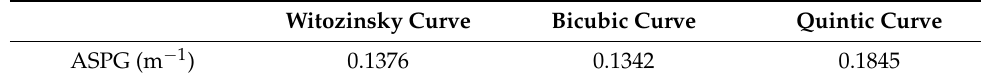
Table 5. ASPG of three different test sections.